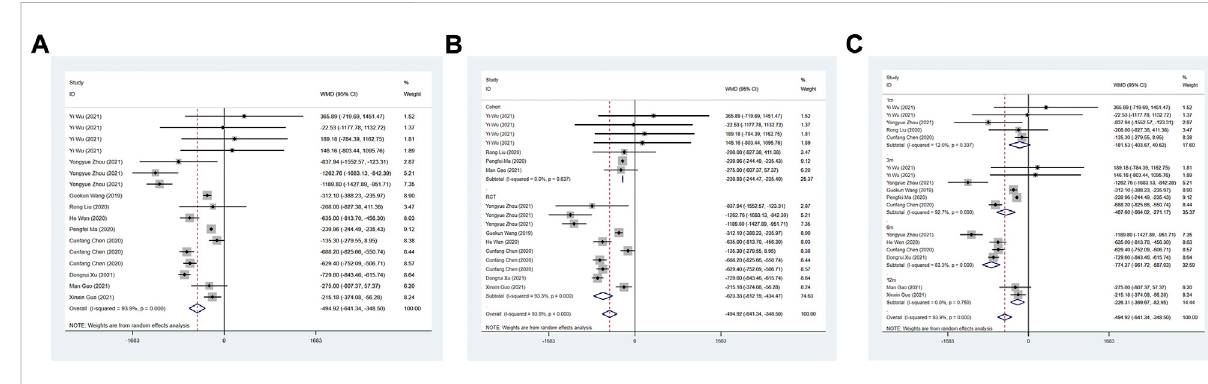
FIGURE 6 Forest plot of NT-proBNP between sacubitril-valsartan and ACEI or ARB; (A) overall; (B) subgroup analysis of study type; (C) duration of treatment.